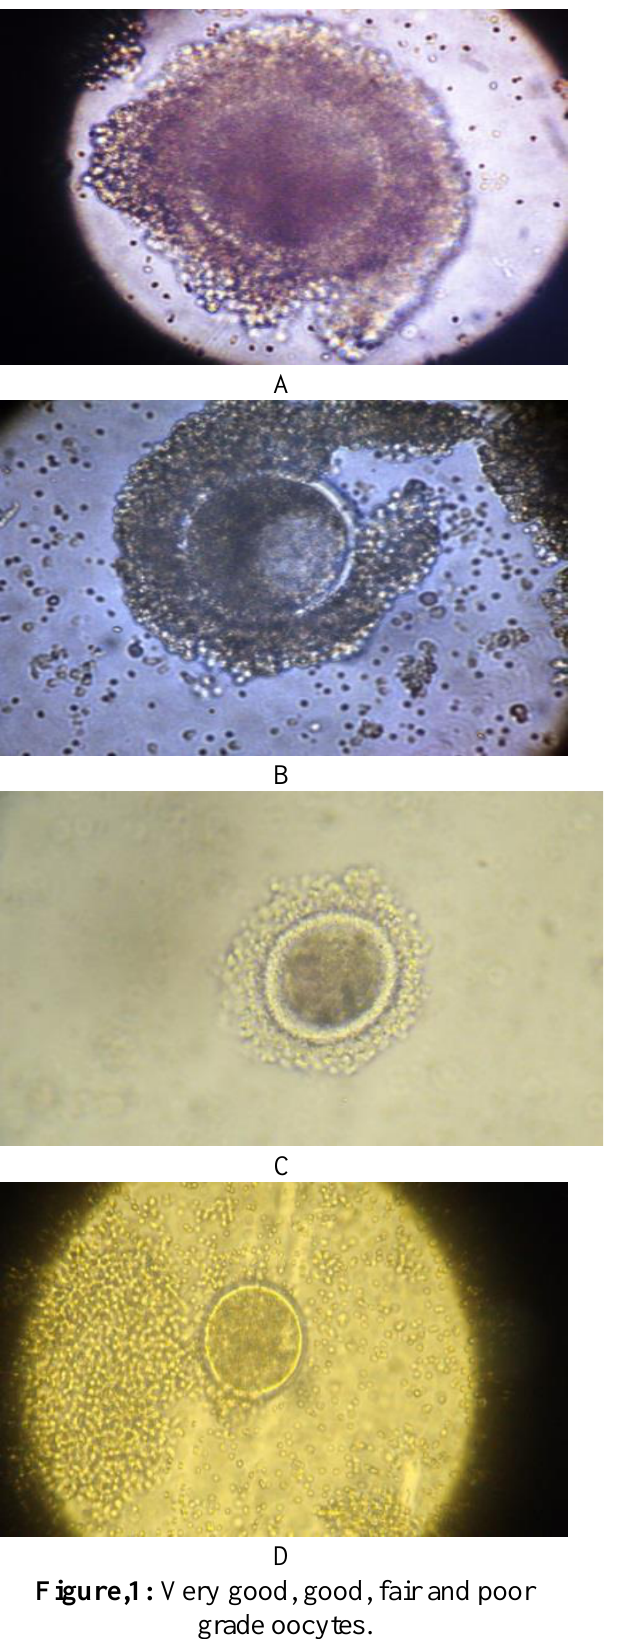
Figure,1: Very good, good, fair and poor grade oocytes.